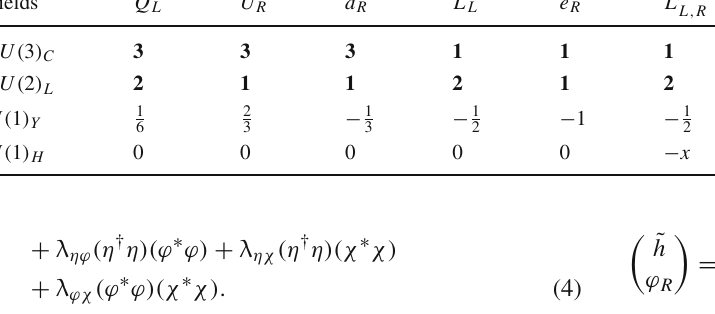
Table 1 Field contents and charge assignment in the model